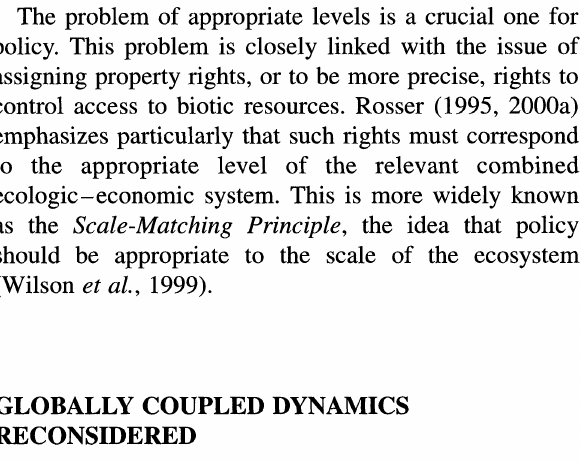
FIGURE 2 Bifurcation of mean-field